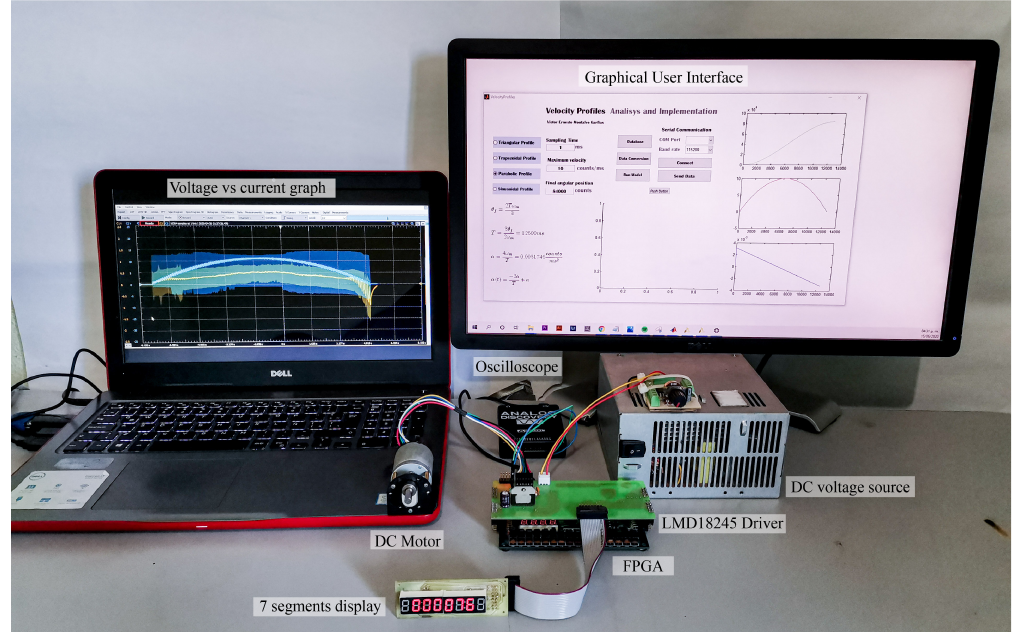
Figure 7. Low-cost platform for industrial applications based on FPGA.